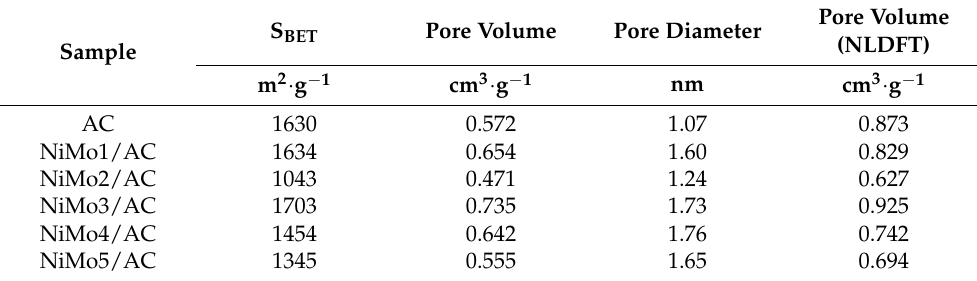
Figure 2. Pore size distribution for ( a ) AC and ( b ) NiMo1/AC, NiMo2/AC, NiMo3/AC, NiMo4/AC, and NiMo5/AC from N 2 adsorption-desorption isotherms at -196 °C. Table 2. Data obtained from the surface area analysis.